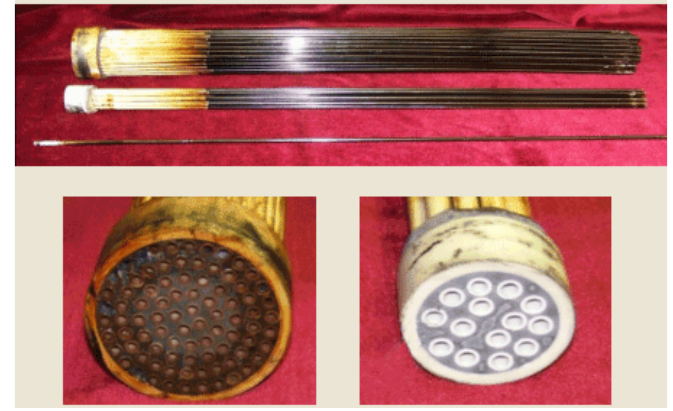
Figure 6. Alumina‐supported CMSM tube pilot scale bundle and full‐scale bundle produced by MPT Figure 6. Alumina-supported CMSM tube pilot scale bundle and full-scale bundle produced by MPT. Reproduced with permission from [90], Elsevier, 2014. Reproduced with permission from [90], Elsevier,